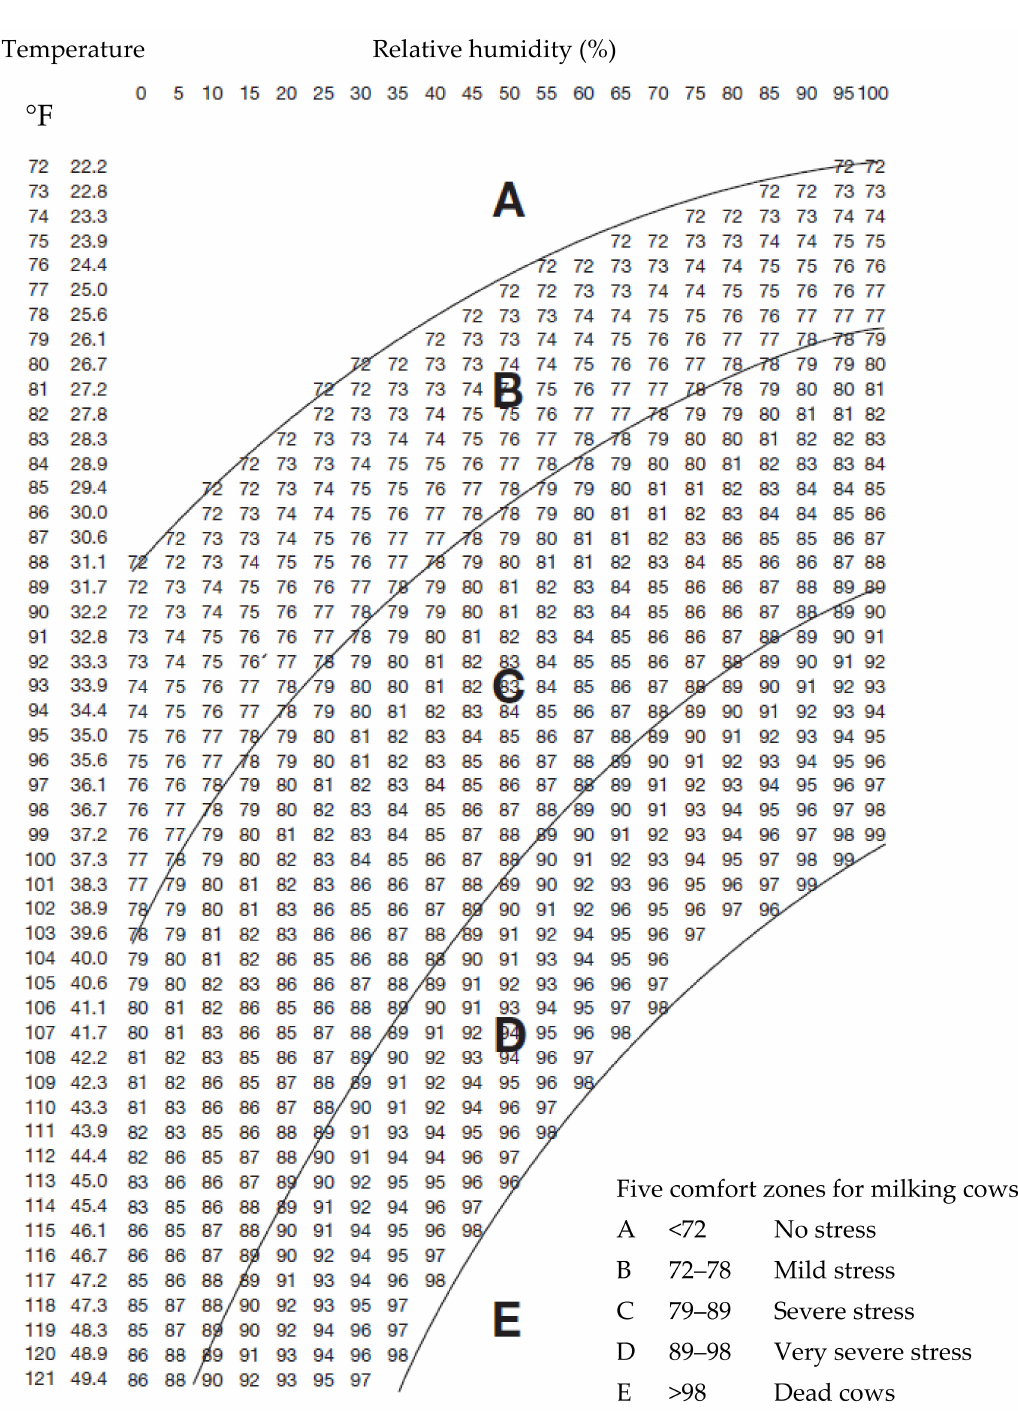
Figure A1. Temperature humidity index (THI) with classification in comfort zones for dairy cattle